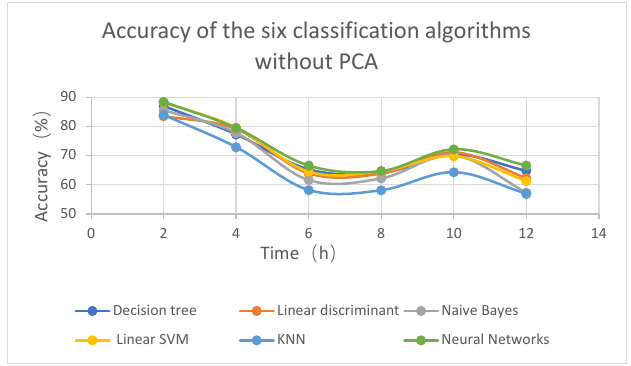
Figure 2. Accuracy of the six classification algorithms without PCA.